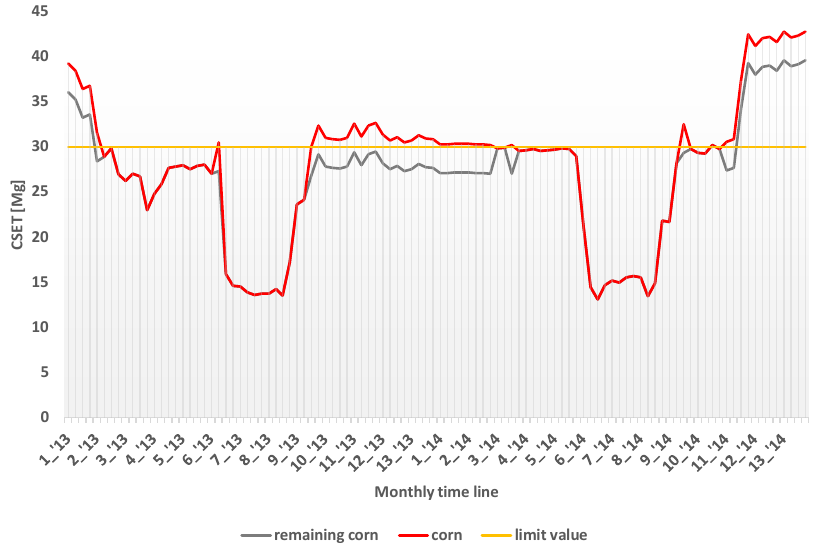
Figure 5. Corn required in the weeks that exceed the threshold value within S2.